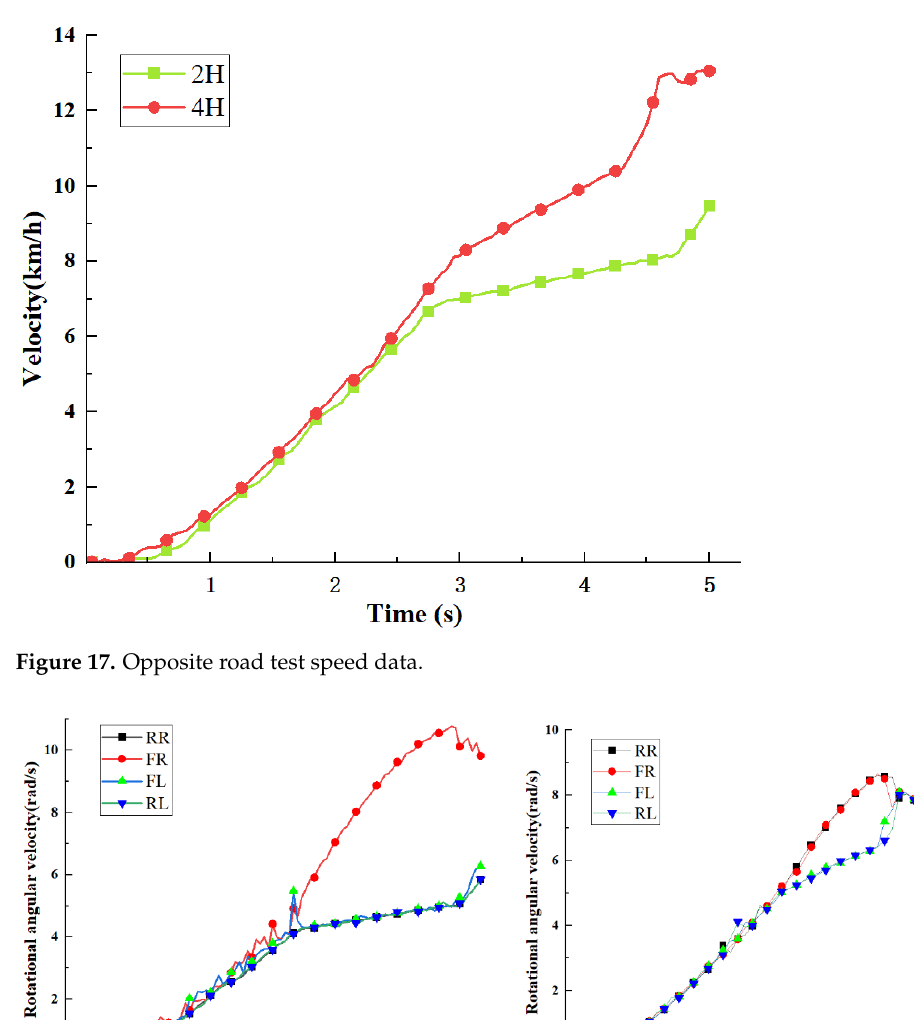
Figure 16. Opposite pavement experiment.